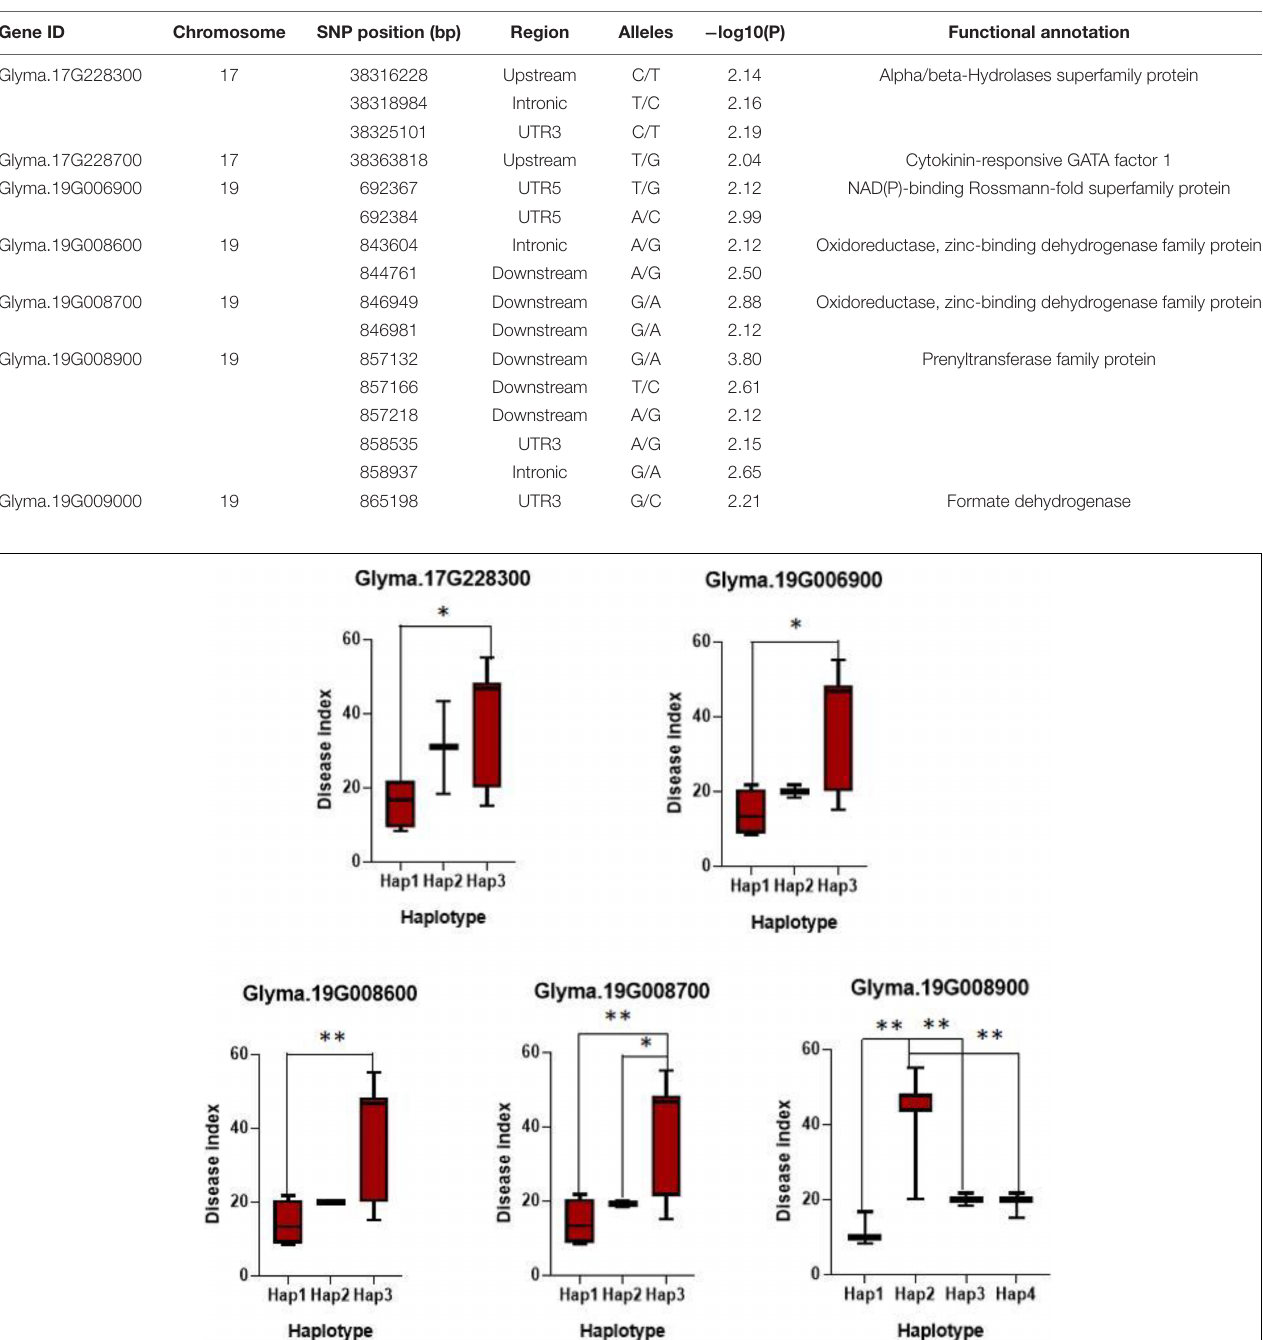
TABLE 3 | Gene-based association analysis of candidate genes.